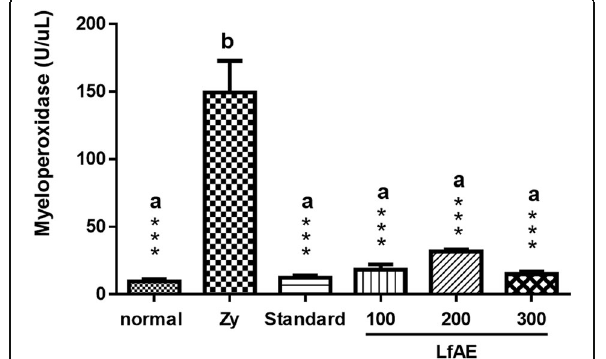
Fig. 3 Effect of LfAE (100, 200 and 300 mgkg) on MPO levels in joint fluid in the zymosan-induced arthritis model. Data are expressed as mean ± SD (One-way ANOVA, Tukey-Kramer test, n = 6 per group). Letters ( a , b ) refer to the result of Tukey-Kramer post hoc test. Groups that do not share a letter have a mean difference that is statistically significant. ***( p < 0.001) vs zymosan control group